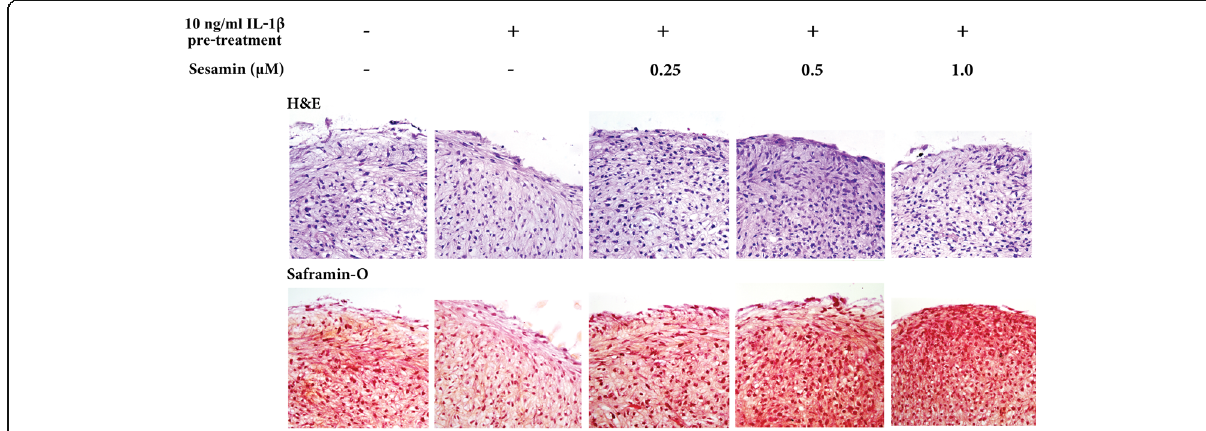
Fig. 6 H&E staining (upper panel) and proteoglycan deposition (lower panel) of HAC pellets on day 21. Chondrocyte mophology and matrices were assessed with H&E staining. The sulfated glycosaminoglycan attached to matix proteoglycans was assessed with safranin-O. Representative sections from one donor are shown at 400×